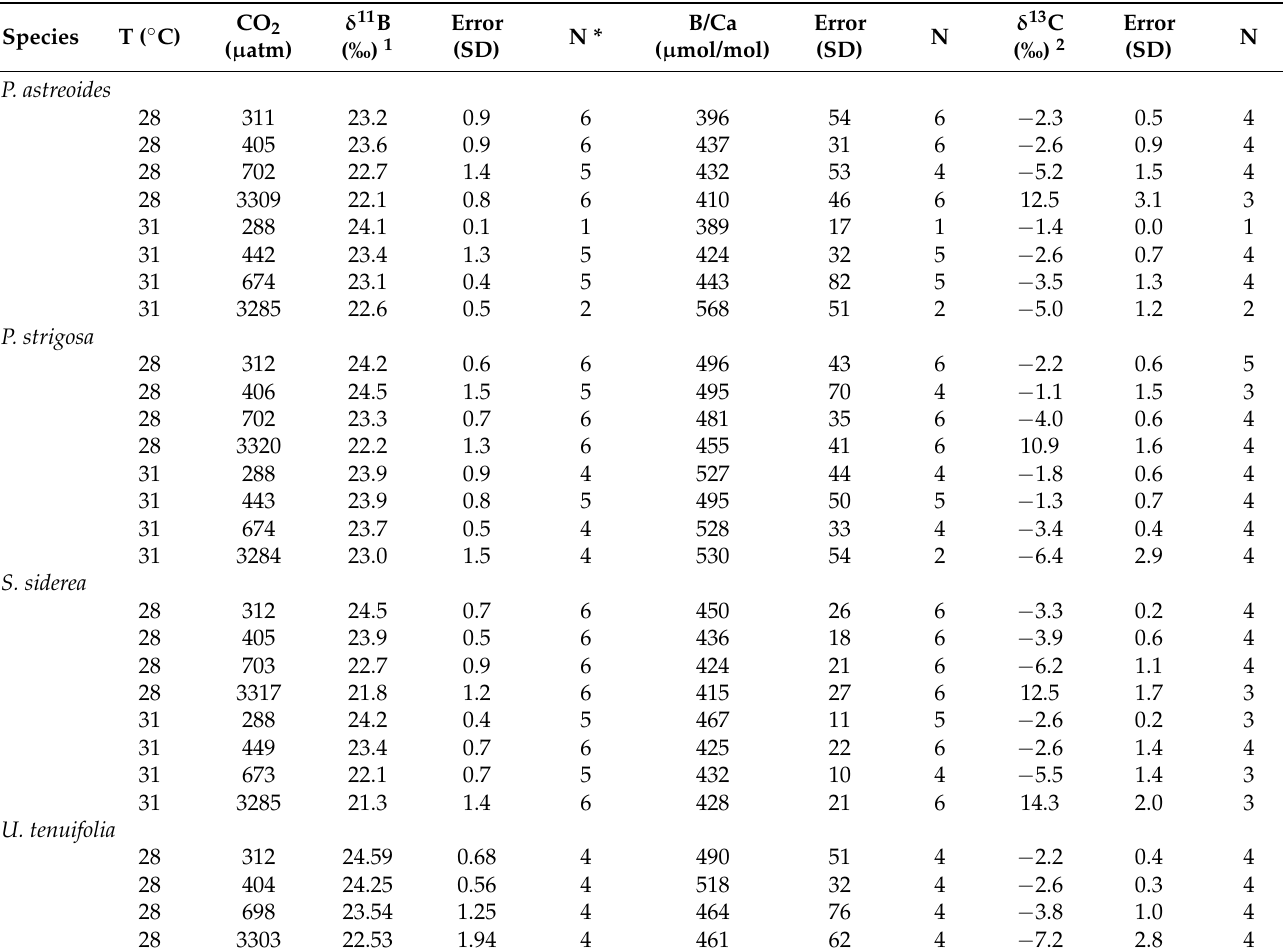
Table 1. Average Geochemical Data per Experimental